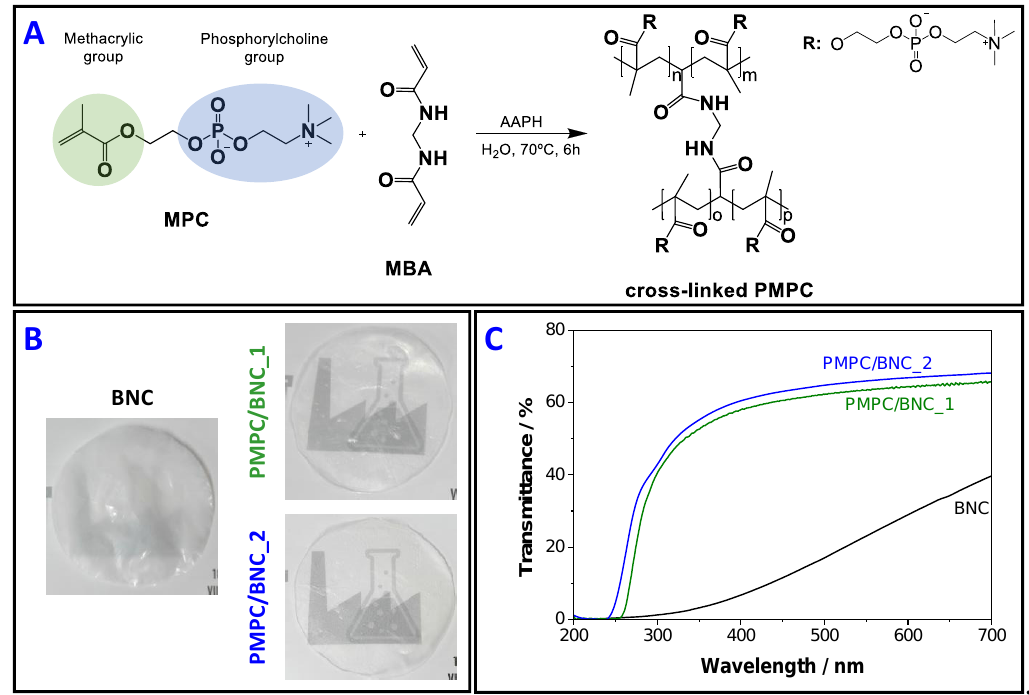
Figure 1. ( A ) Radical polymerization of MPC in the presence of MBA as cross-linker, yielding cross-linked PMPC, ( B ) photographs of neat BNC and nanocomposites PMPC/BNC_1 and PMPC/BNC_2, and ( C ) the corresponding UV-visible transmission spectra. Table 1. List of the studied membranes with the respective weight compositions and thicknesses.